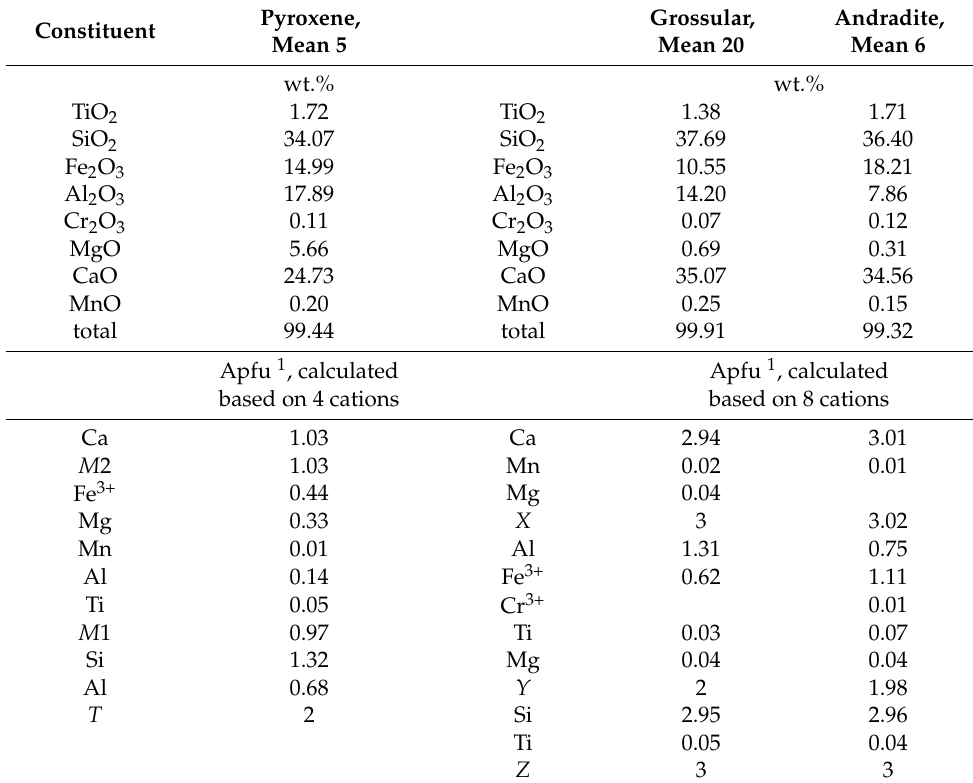
(Table 3). Fluorapatite is sporadically met in this rock; it forms skeletal crystals up to 90 µ m in size. Table 3. Chemical composition of pyroxene and garnets from the zeolite-bearing